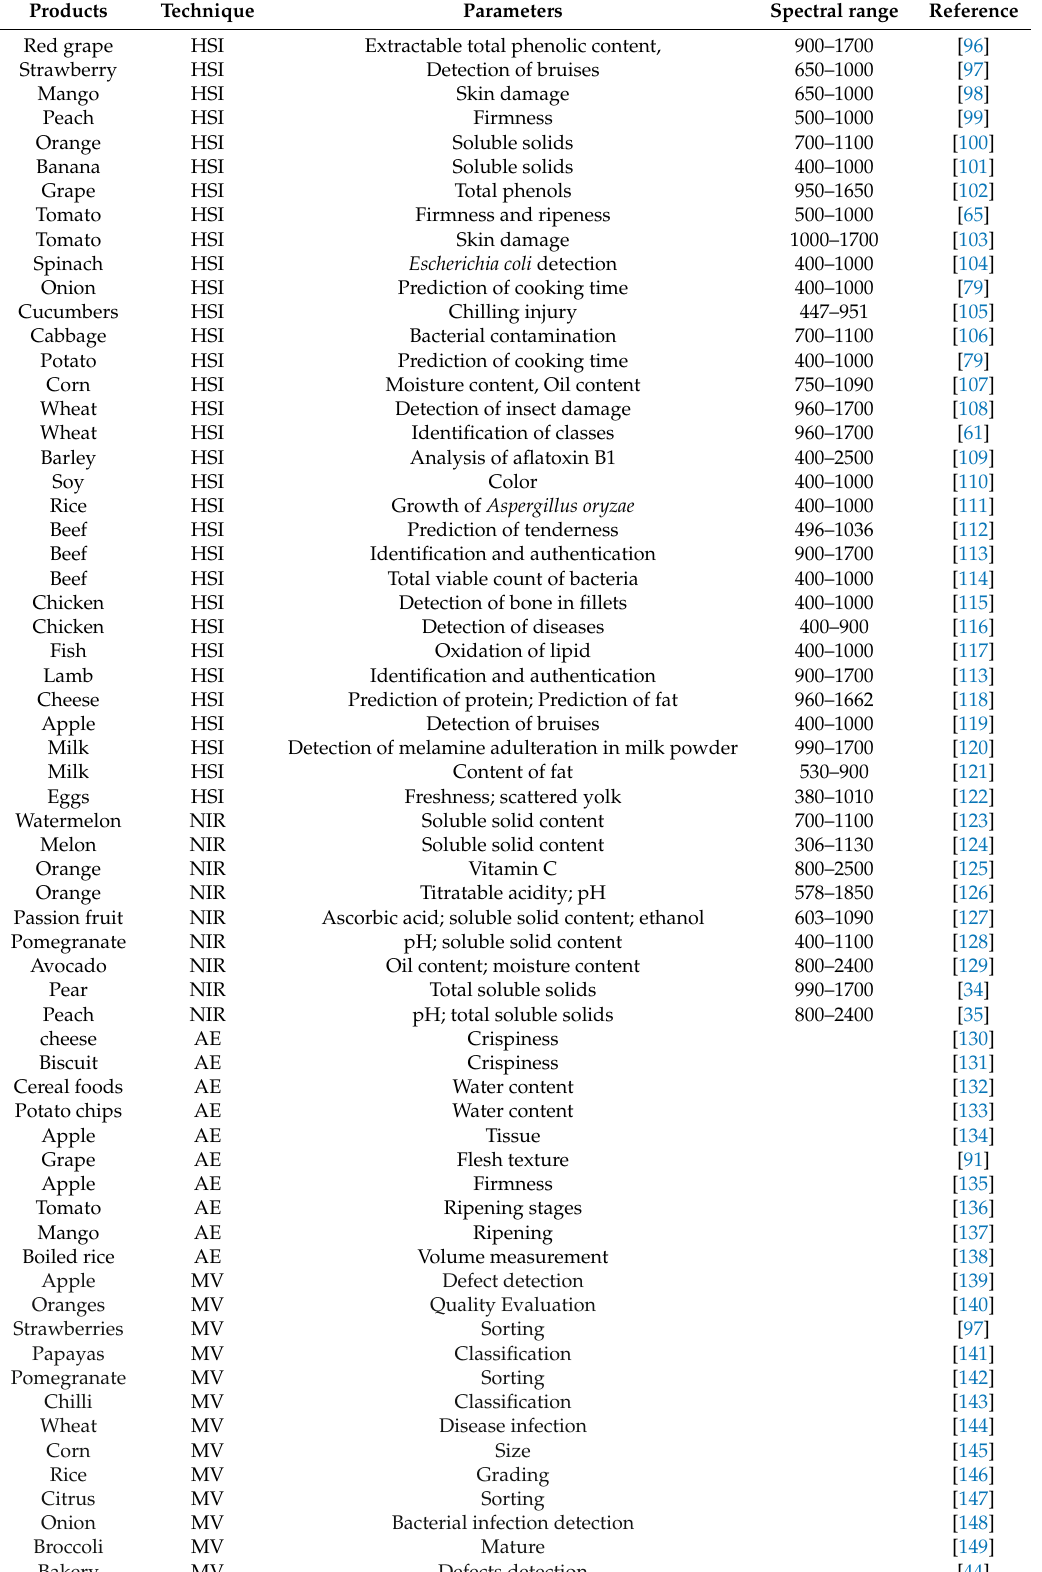
Table 3. Summary of non-destructive applications to evaluate the quality and safety of agricultural and food